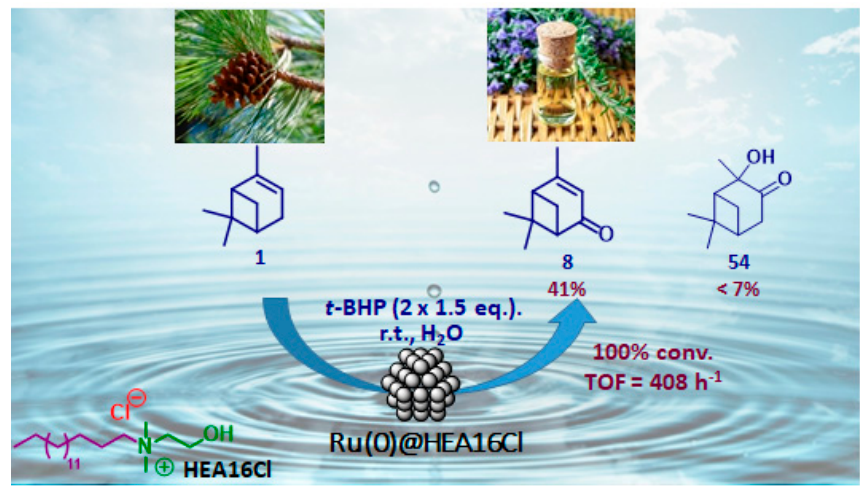
Figure 16. Ammonium surfactant-stabilized ruthenium nanoparticles for oxidation of α -pinene 1 in neat water (adapted from reference [90]).